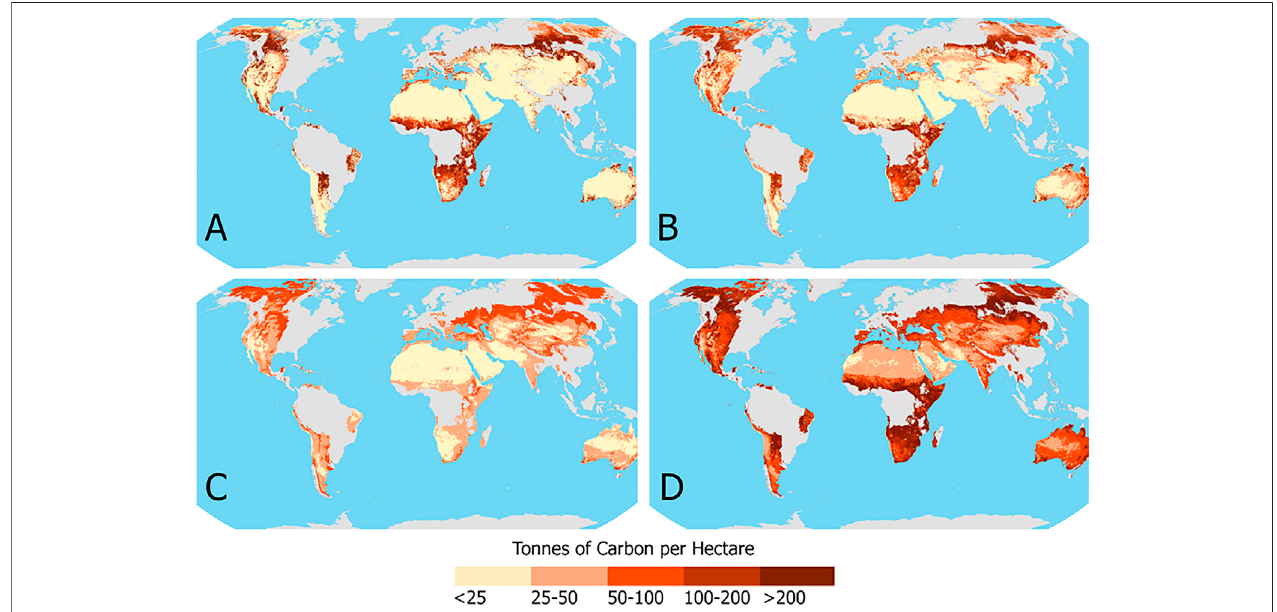
FIGURE2| Mapsshowingglobaldrylandcarbonstocks(Mgha − 1 ofC)in (A) abovegroundplantbiomass, (B) belowgroundplantbiomass, (C) soilorganicmatter (0 – 30 cm),and (D) thesummedtotalcarbon stocks(total (cid:1) A+B+C). Dataused toconstruct thesemaps arefromSpawn andGibbs,2020,availableattheOakRidge National Laboratories Distributed Active Archive Center (https://doi.org/10.3334/ORNLDAAC/1763) for biomass in above- and below-ground vegetation, and from Safriel, 2017 for carbon in the upper soil horizons (30